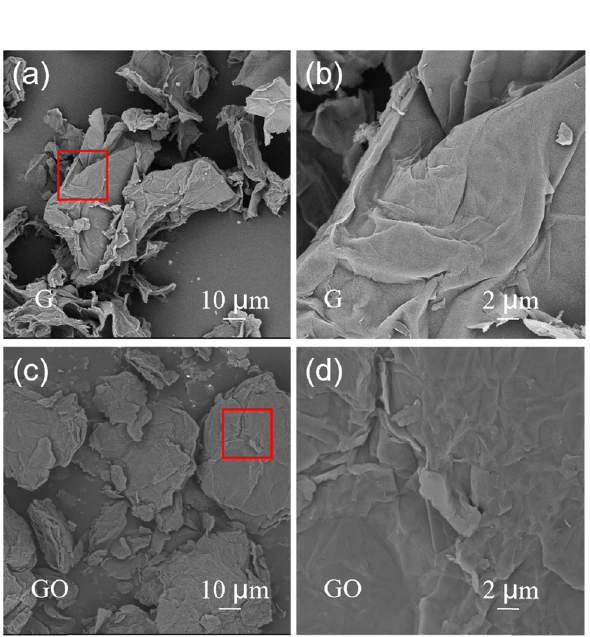
Figure 1: SEM image of G ( a ) and ( b ) and GO ( c ) and ( d )